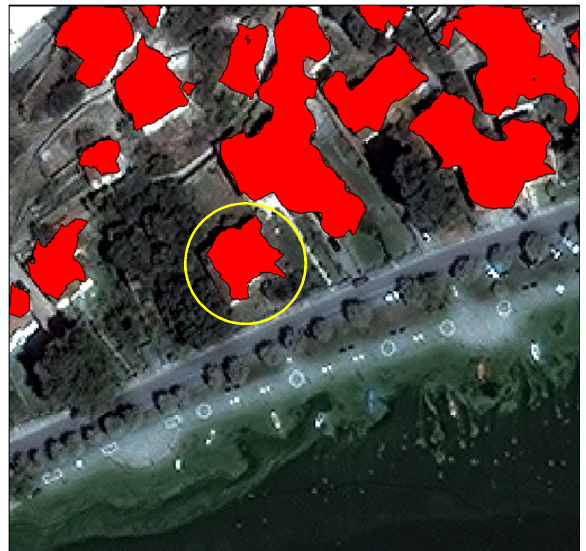
Figure 6. Roofs in red color acquired from QuickBird subset image through object-oriented feature extraction (roof of Skoutaris Mansion in the yellow